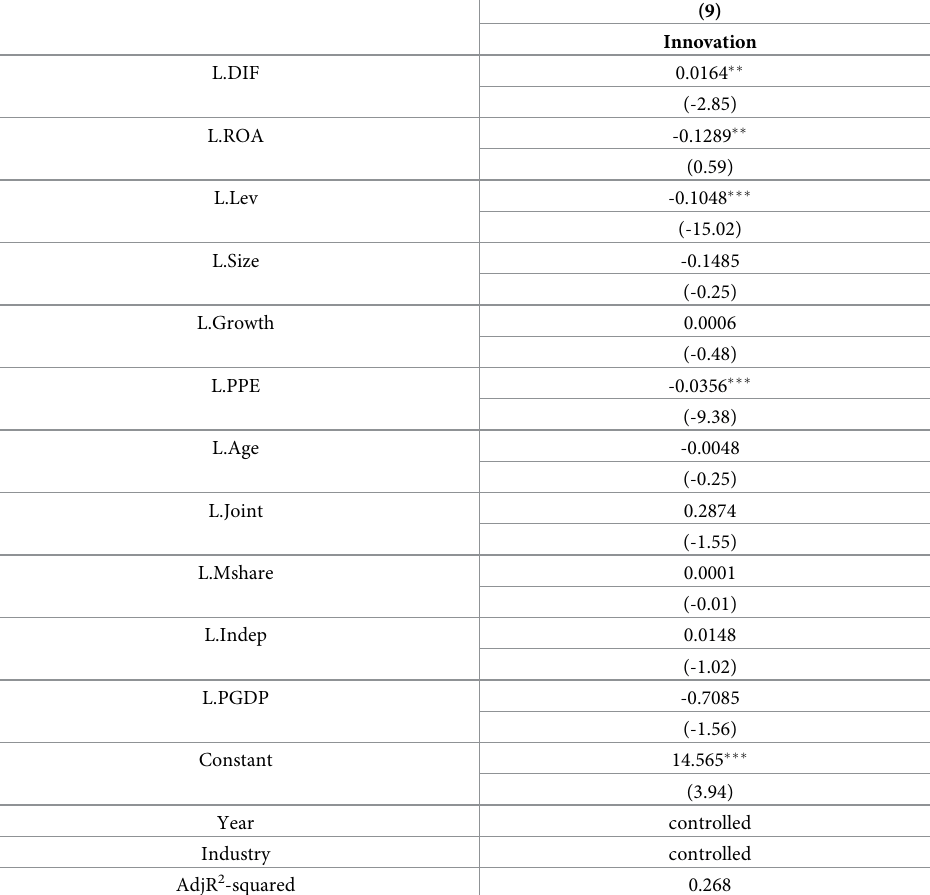
Table 4. The regression results of the endogeneity